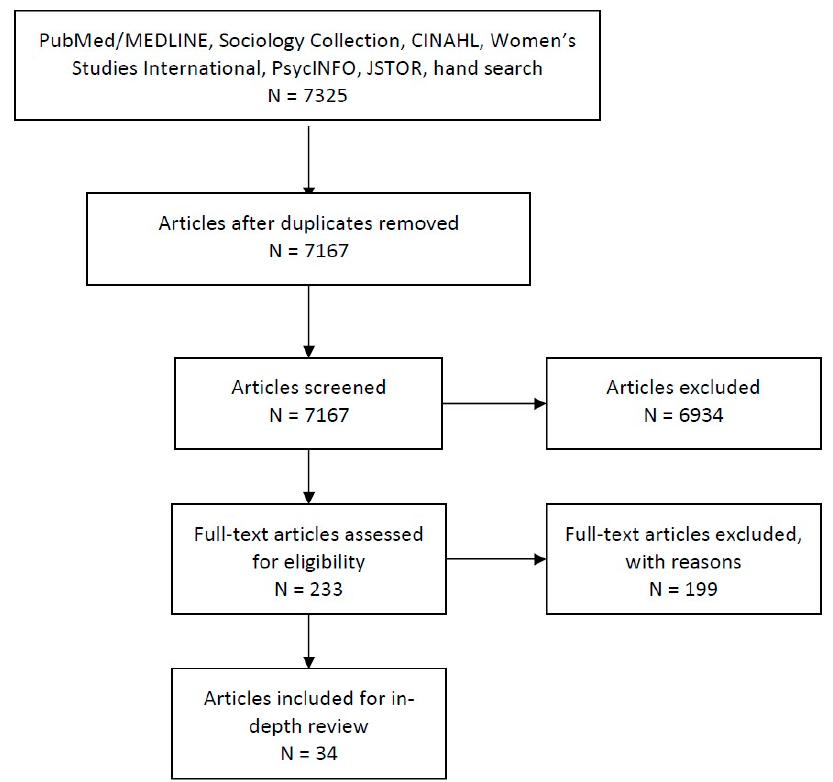
Figure 1. PRISMA chart of article selection.